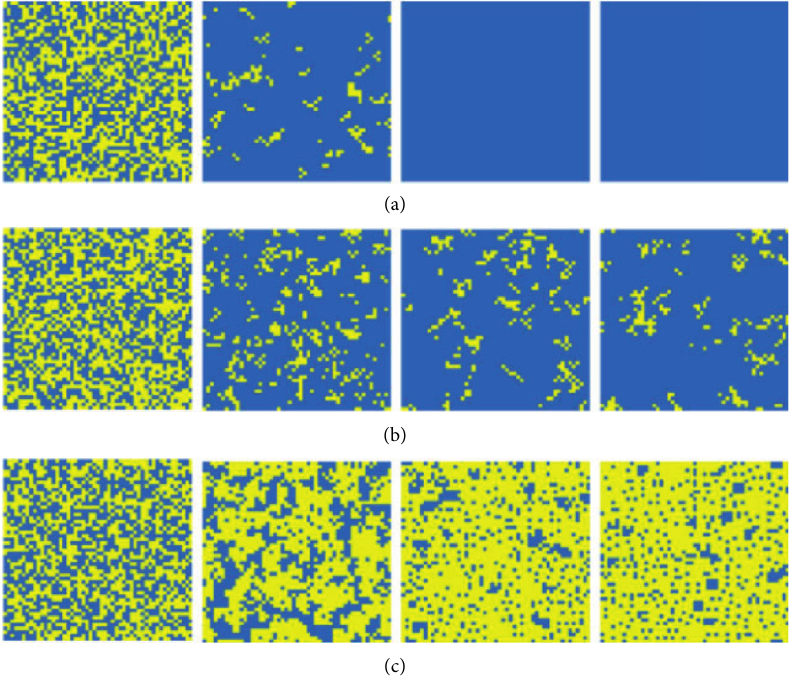
Figure 13: Characteristic snapshot of cooperators (yellow) and defectors (blue) for different values of the parameters u and α . (a) The traditional type ( u � 0 and α � 0), (b) the coexistence of environmental heterogeneity and preference ( u � 0.2 and α � 1), and (c) the larger heterogeneity of environment and environmental preference ( u � 0.7 and α � 4). From left to right, the simulation steps are 0, 5, 50, and 500. The depicted are obtained for r � (Figure 7). For example, when α � 5, environmental prefer- ence increases the density of cooperation from 0 to 0.7.